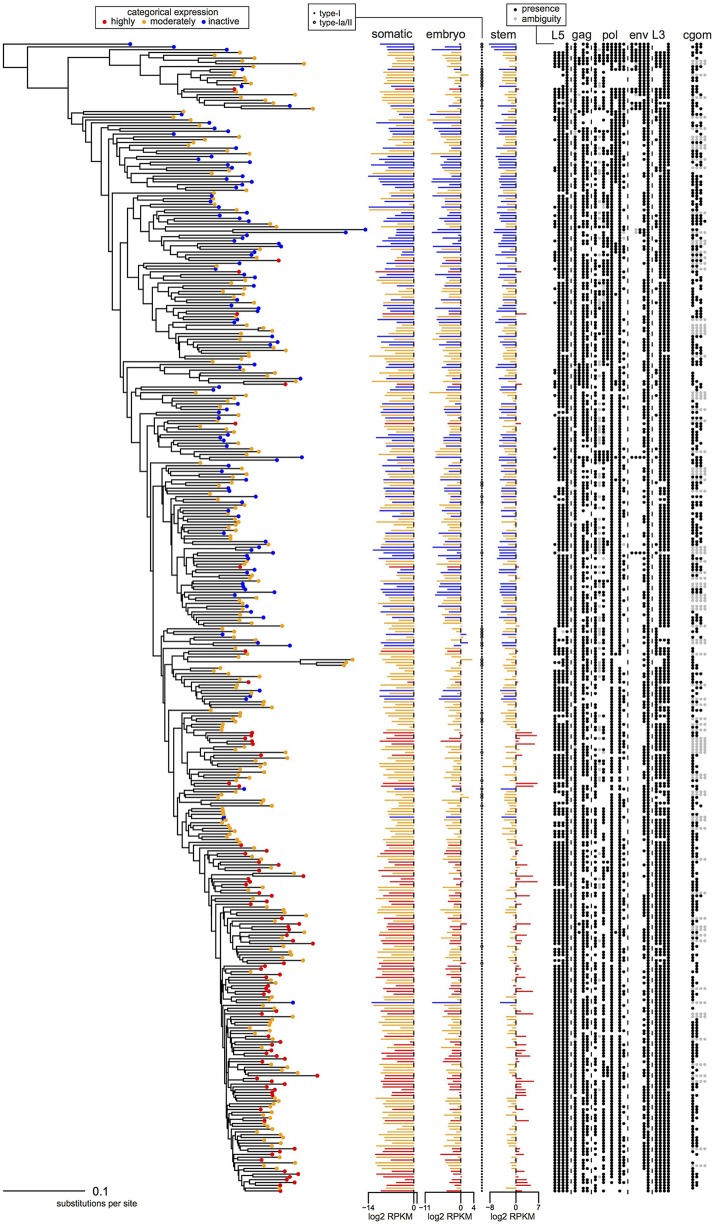
Phylogeny, transcription levels, and per locus genomic features of the 409 HERV-H loci from the human genome that were analyzed using PGLS. Loci are colored according to the categorical transcription levels of Wang et al. (7): highly active (red); moderately active (orange); inactive (blue). Columns L5, gag, pol, env, and L3 indicate the presence/absence of regions L5/1–L5/4, G1–G4, P1–P8, E1–E5, and L3/1–L3/4, respectively; column cgom indicates the substantive presence/absence of each locus in chimpanzee, gorilla, orangutan, and macaque.